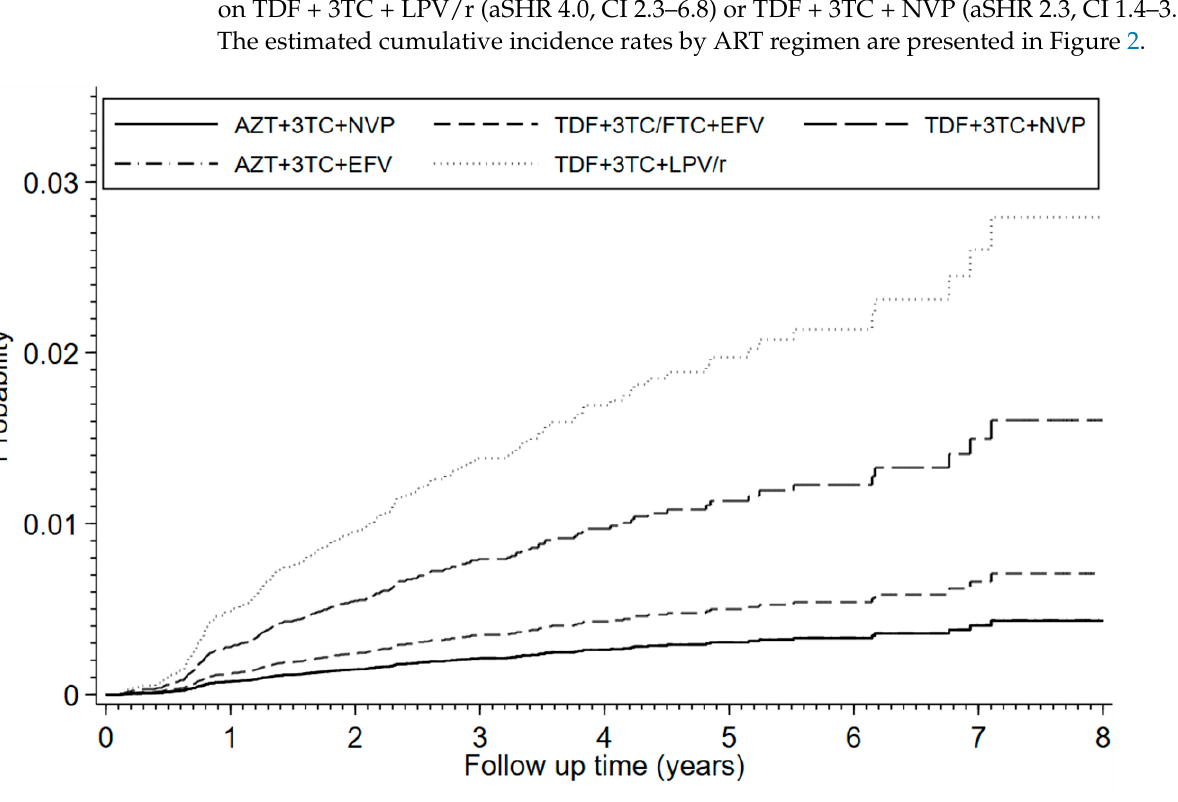
Figure 2. Cumulative incidence function of chronic kidney disease, accounting for deaths without prior CKD diagnosis as competing events. Analyses were adjusted for sex, age, history of type 2 diabetes, hypertension, gout, urolithiasis, serum creatinine levels, and propensity score stratification. The follow-up time was from ART initiation until last visit, switching of ART regimen, loss to follow up, end of study, death or confirmed diagnosis of CKD, whichever occurred first. The overall